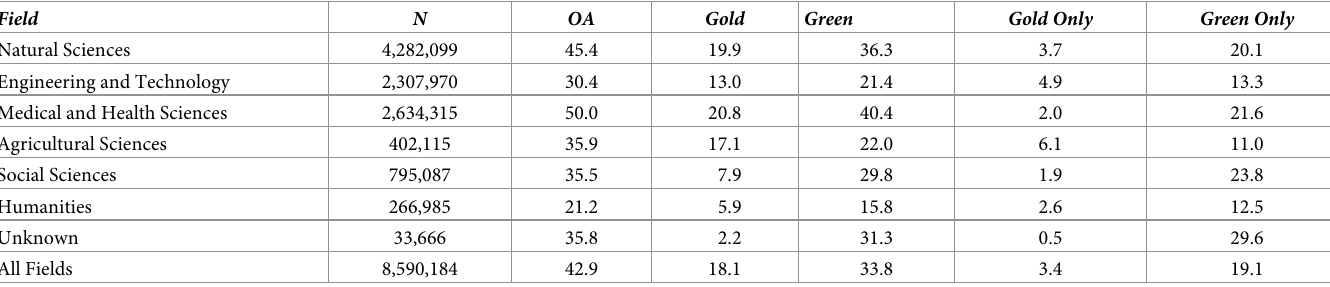
Table 1. Proportion of OA publications by type and by fields